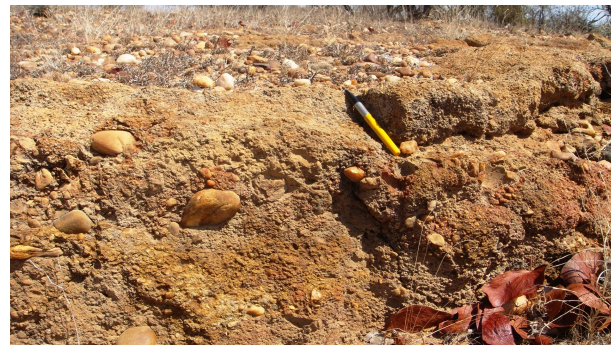
Figure 13. Weathered, incised and terraced river gravels at the apex of the megafan (photographer: De Dapper, 2009).